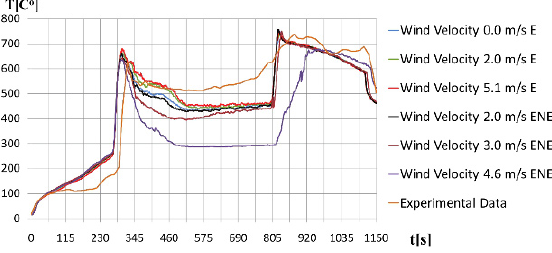
Figures 11 and 12 show velocity field in two time instance of the fire. The section 3.3 X and 4.6 Y are